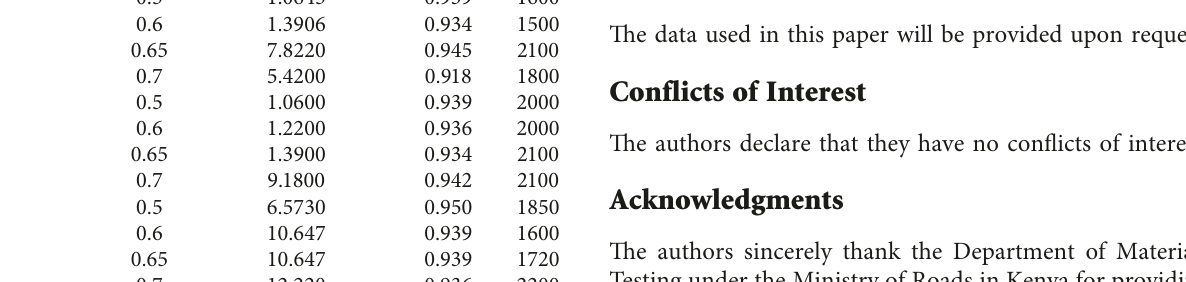
Table 7: D 2 Values after exposure to WLI for SO 42 − . app and r Cement